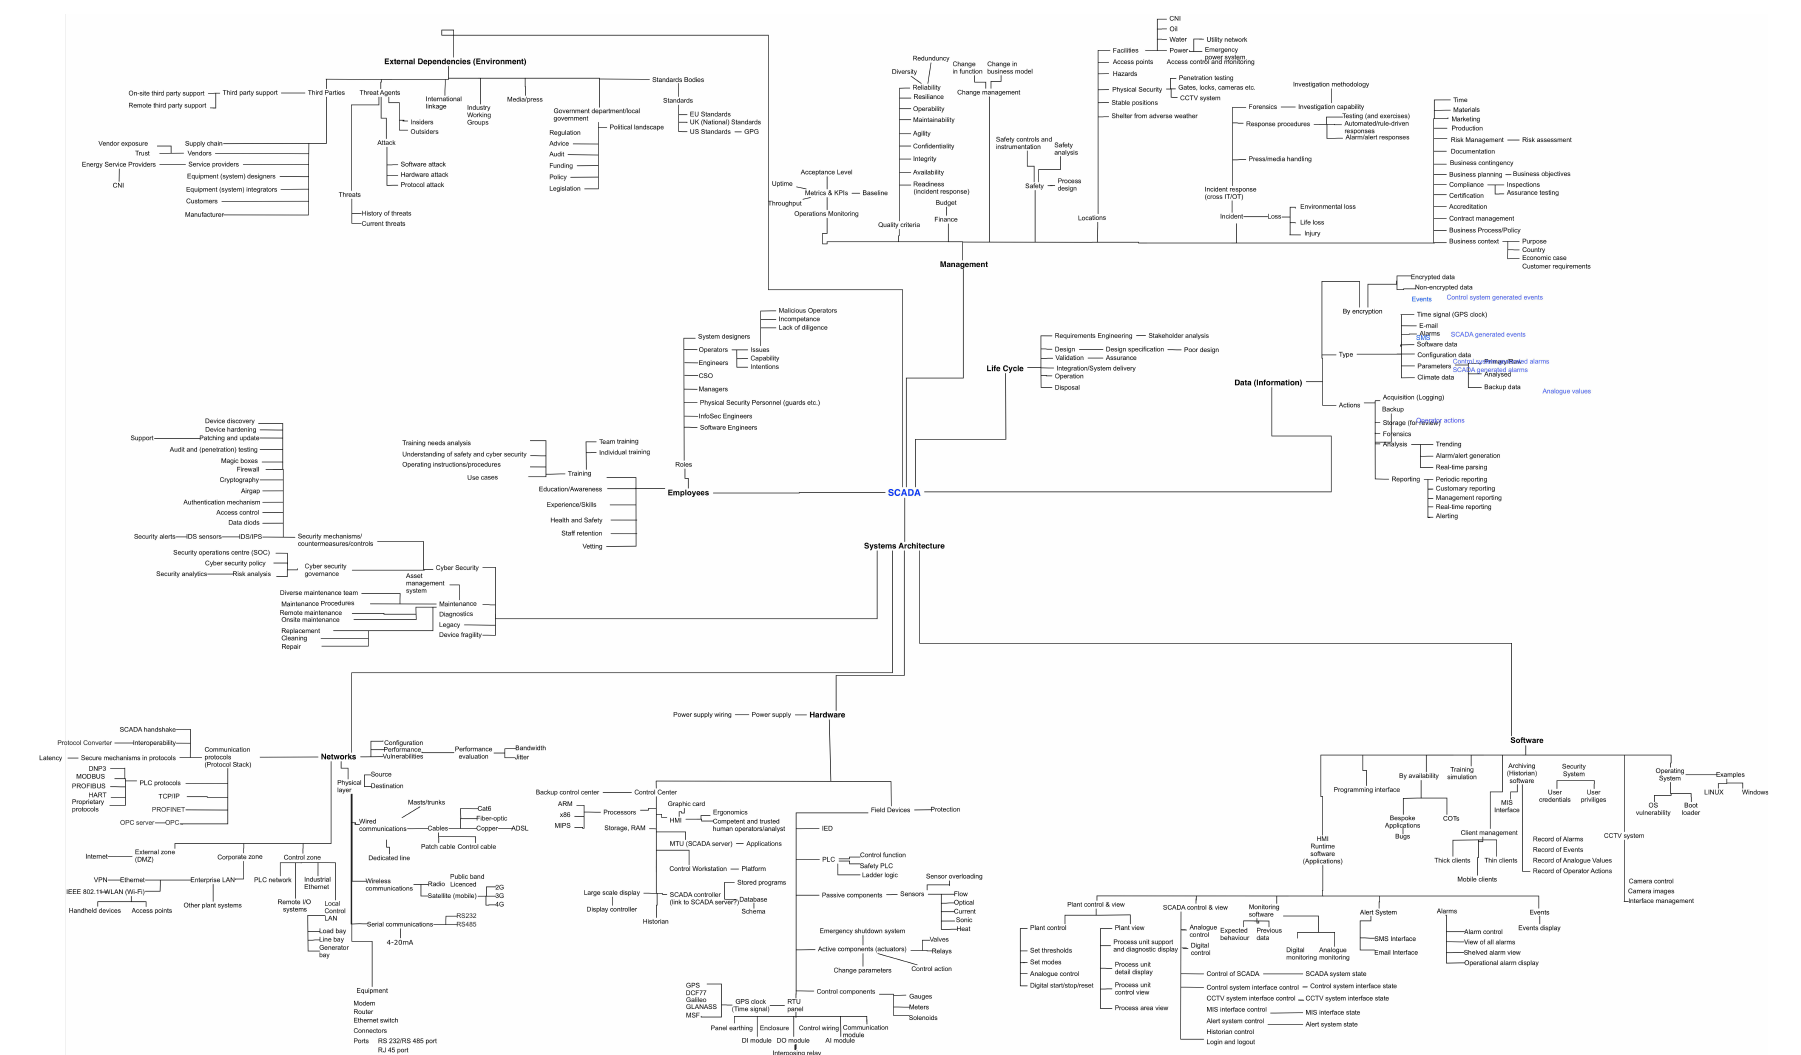
Figure 1. An Early Version of the Unified SCADA Mind